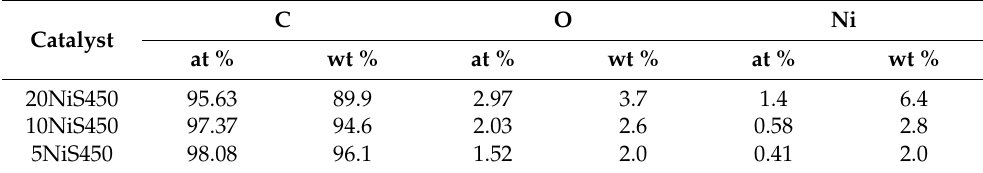
Figure 4. X-ray diffraction patterns of the nickel catalysts based on the Sibunit carbon material with nickel contents of 5, 10, and 20%. Table 2. XPS elemental composition of the catalyst